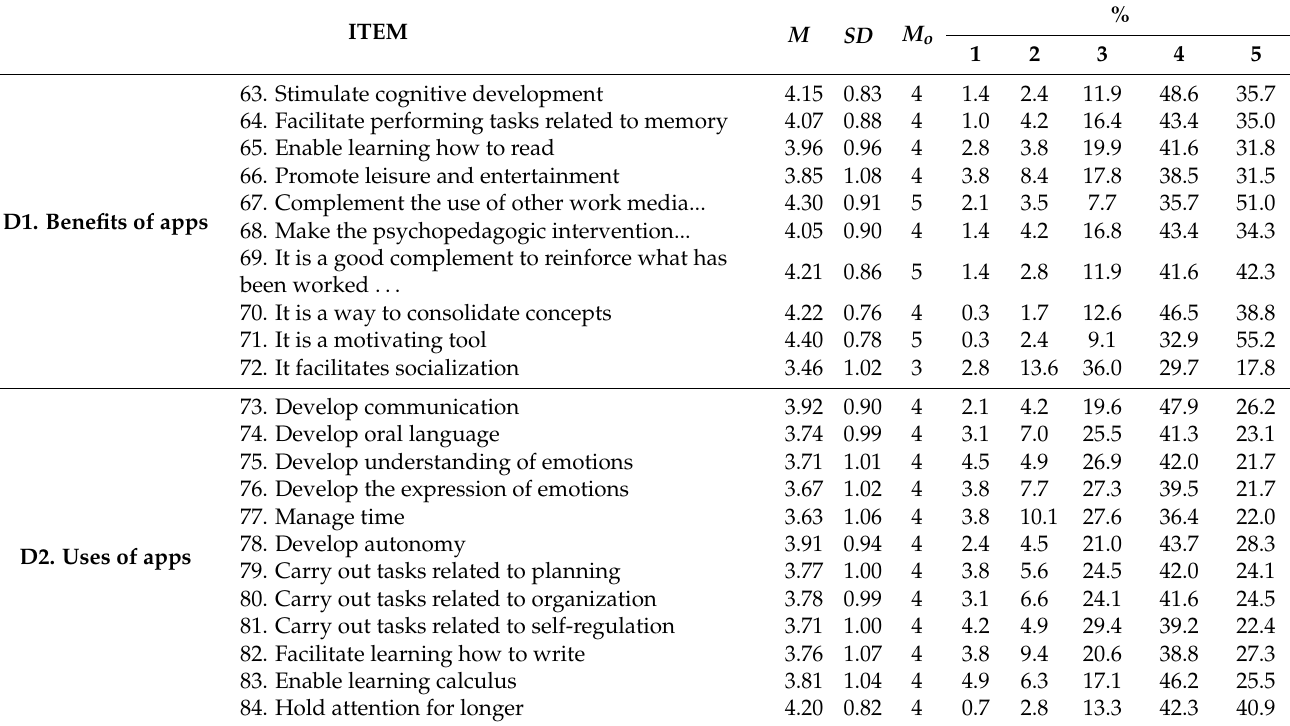
Table 3. Opinion of teachers from Granada and Florence about the benefits and uses of apps for attending to people with autism ( N = 286).